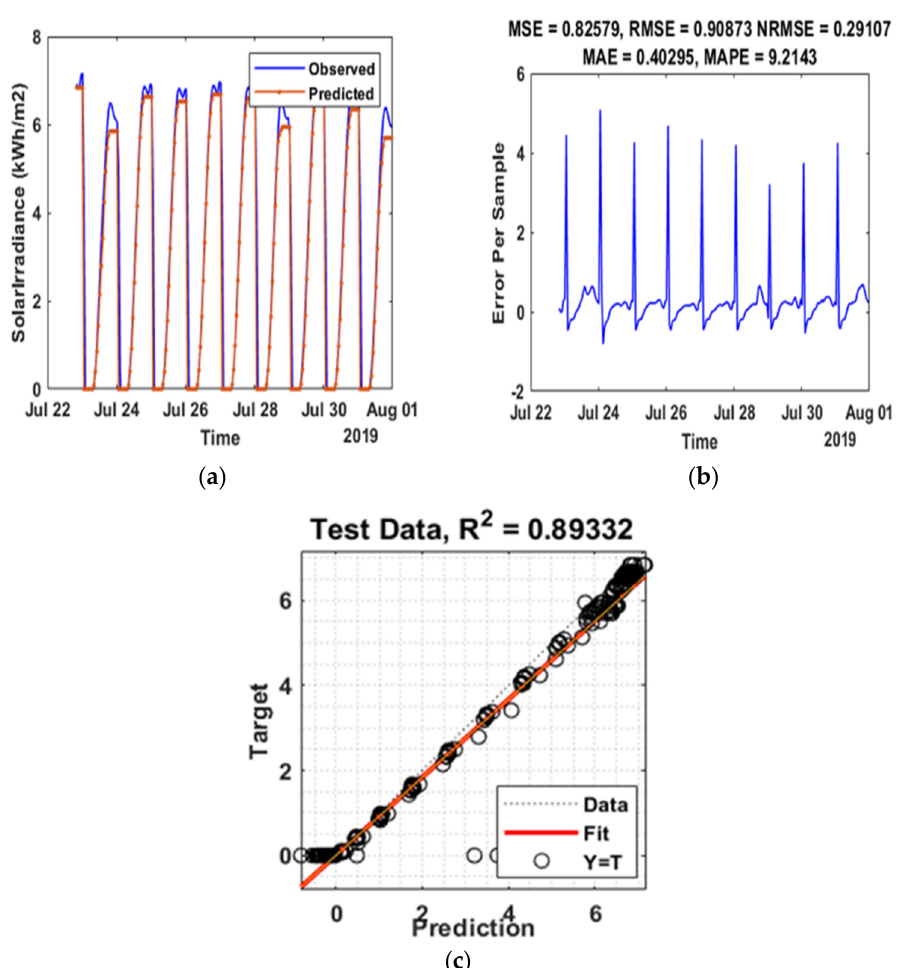
Figure 7. ( a ) The observed and predicted results, ( b ) error metrics and ( c ) regression plot considering solar irradiance-Sweihan photovoltaic independent power project, Abu Dhabi-for LSTM.